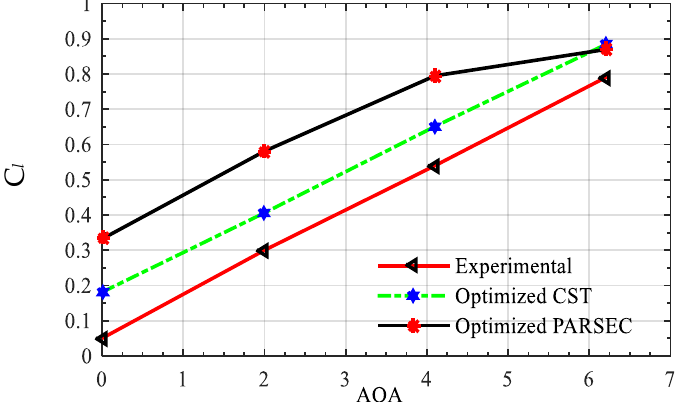
Figure 10. Variation of lift coefficient with the angle of attack for the S809 airfoil.